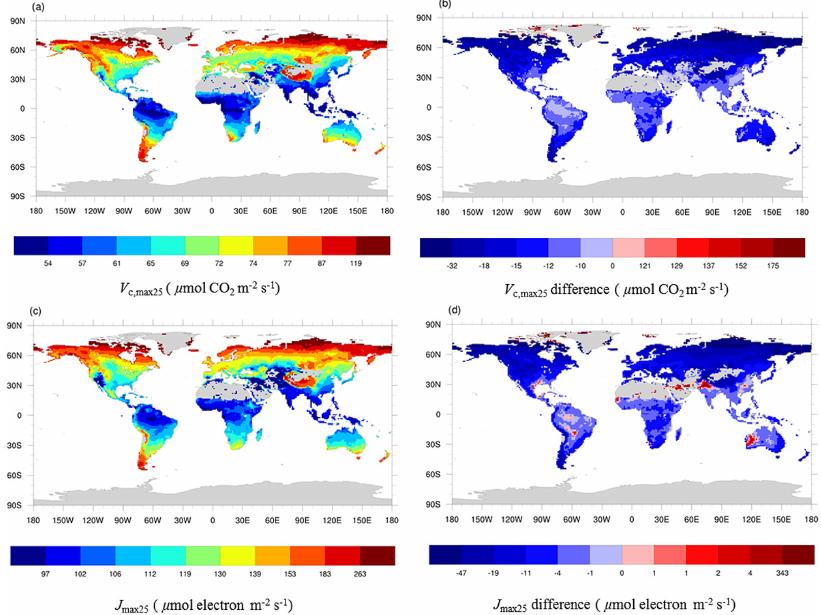
Figure 4. Summer-season photosynthetic capacity for the top leaf layer in the canopy under historical climatic conditions ( a : V c , max25 (µmolCO 2 m − 2 s − 1 ), b : J max25 (µmolelectronm − 2 s − 1 ) ) and the difference in either V c,max25 (b) or J max25 (d) due to changed climatic conditions in the future. The difference is calculated by subtracting the photosynthetic capacity predicted by the LUNA model under the historical climate conditions from that under the future climate conditions. The historical climate is represented by the 10-year monthly averages over years 1995–2004 and the future climate is represented by the 10-year monthly averages over years 2090–2099. The model is run by using TRF1, which is a temperature response function that considered the thermal acclimation.